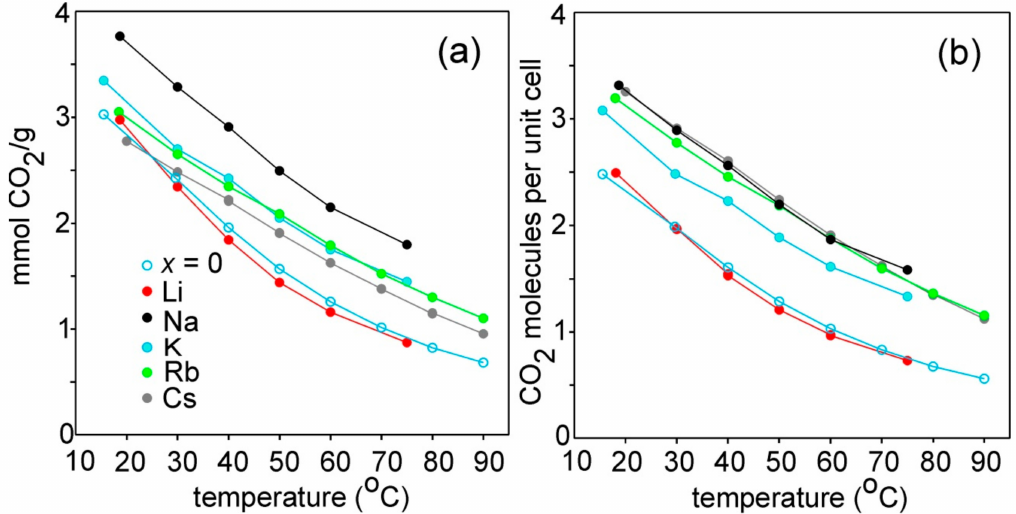
Figure 7. Thermogravimetrically determined adsorbed amount on A 2 / 3 Cu[Fe(CN) 6 ] 2 / 3 compounds and Cu[Fe(CN) 6 ] 2 / 3 ( x = 0) as a function of temperature: ( a ) as mmol CO 2 / g; ( b ) as CO 2 molecules per unit